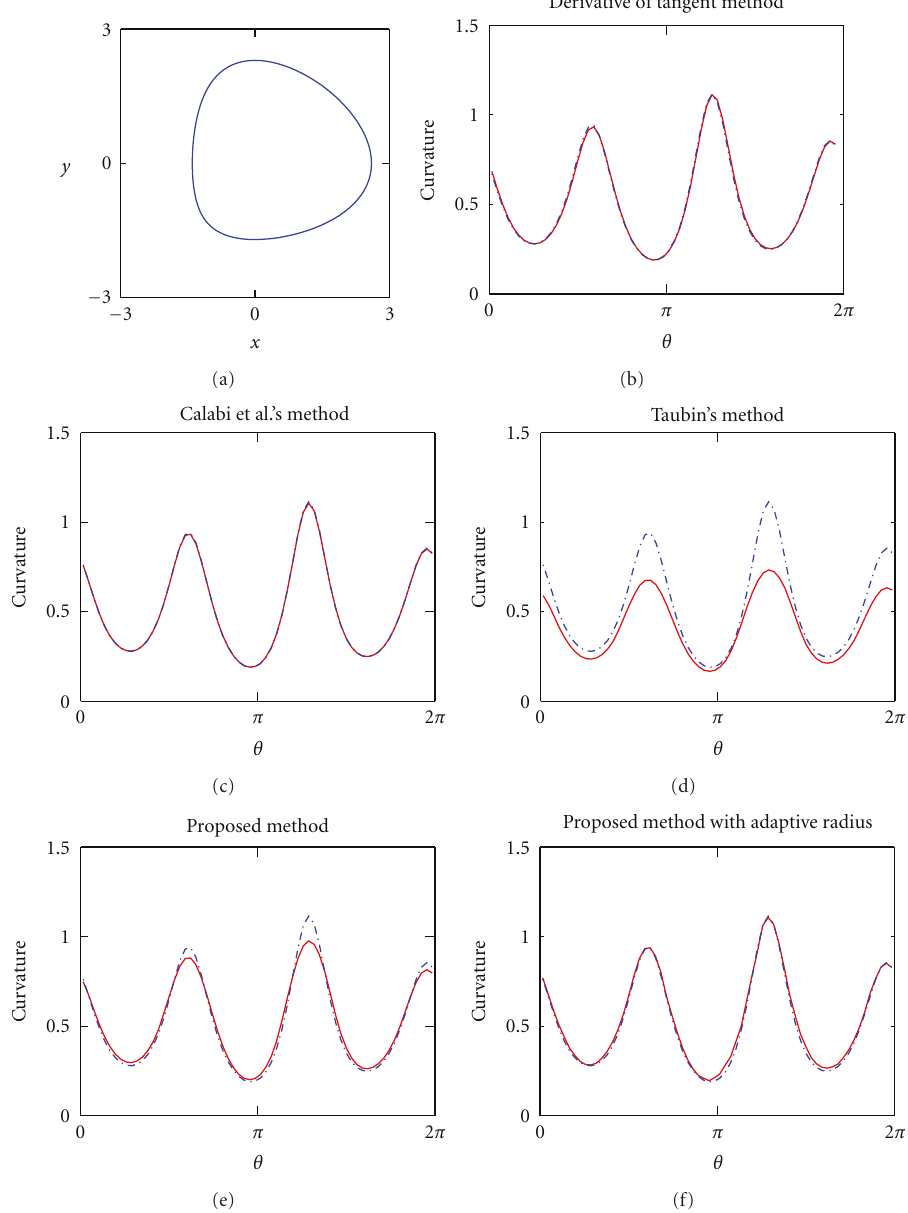
Figure 8: (a) The closed curve { x = 2cos θ + (3 / 5)cos 2 θ , y = 2sin θ + (3 / 10)sin 2 θ | θ ∈ [0,2 π ] } , (b) curvature estimate obtained by derivative of tangent, (c) curvature estimate obtained by Calabi et al.’s algorithm, (d) curvature estimate obtained by Taubin’s algorithm, (e) curvature estimate obtained by line integrals, and (f) curvature estimate obtained by line integrals with adaptive radius. Notice that a dashed blue line denotes the true